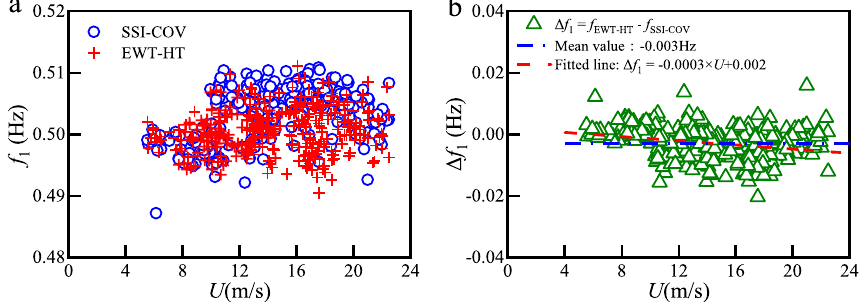
Fig. 12 Measured modal frequencies of first-order vertical bending of PSRB: a Two identification methods; b Difference between two identification